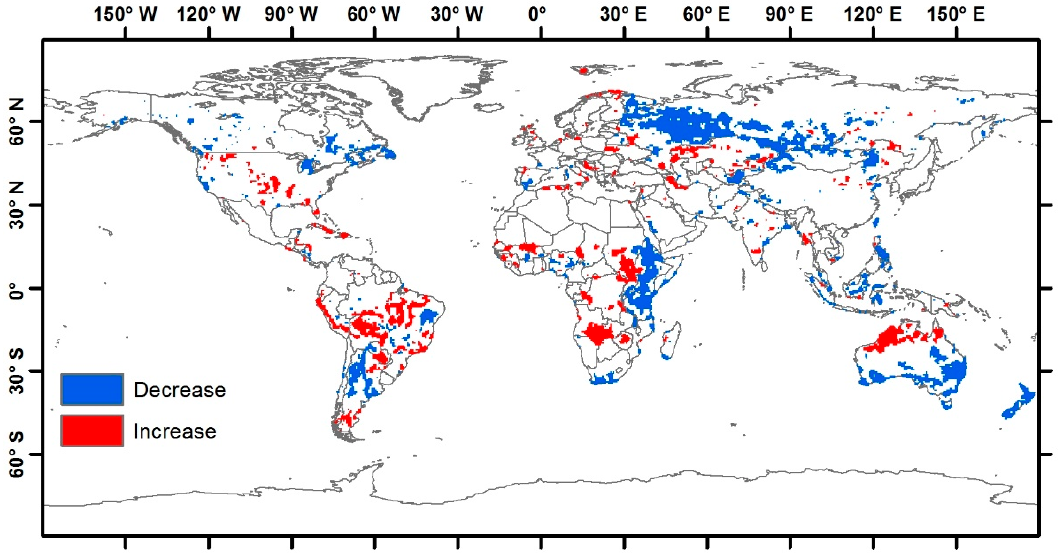
Figure 11. Significant trends of BA (with a confidence level of 95%) in the long-term series from 1982 to 2018 (FireCCILT11) at 0.5° resolution.